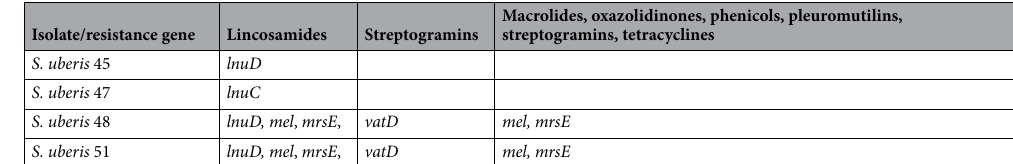
Isolate/resistance